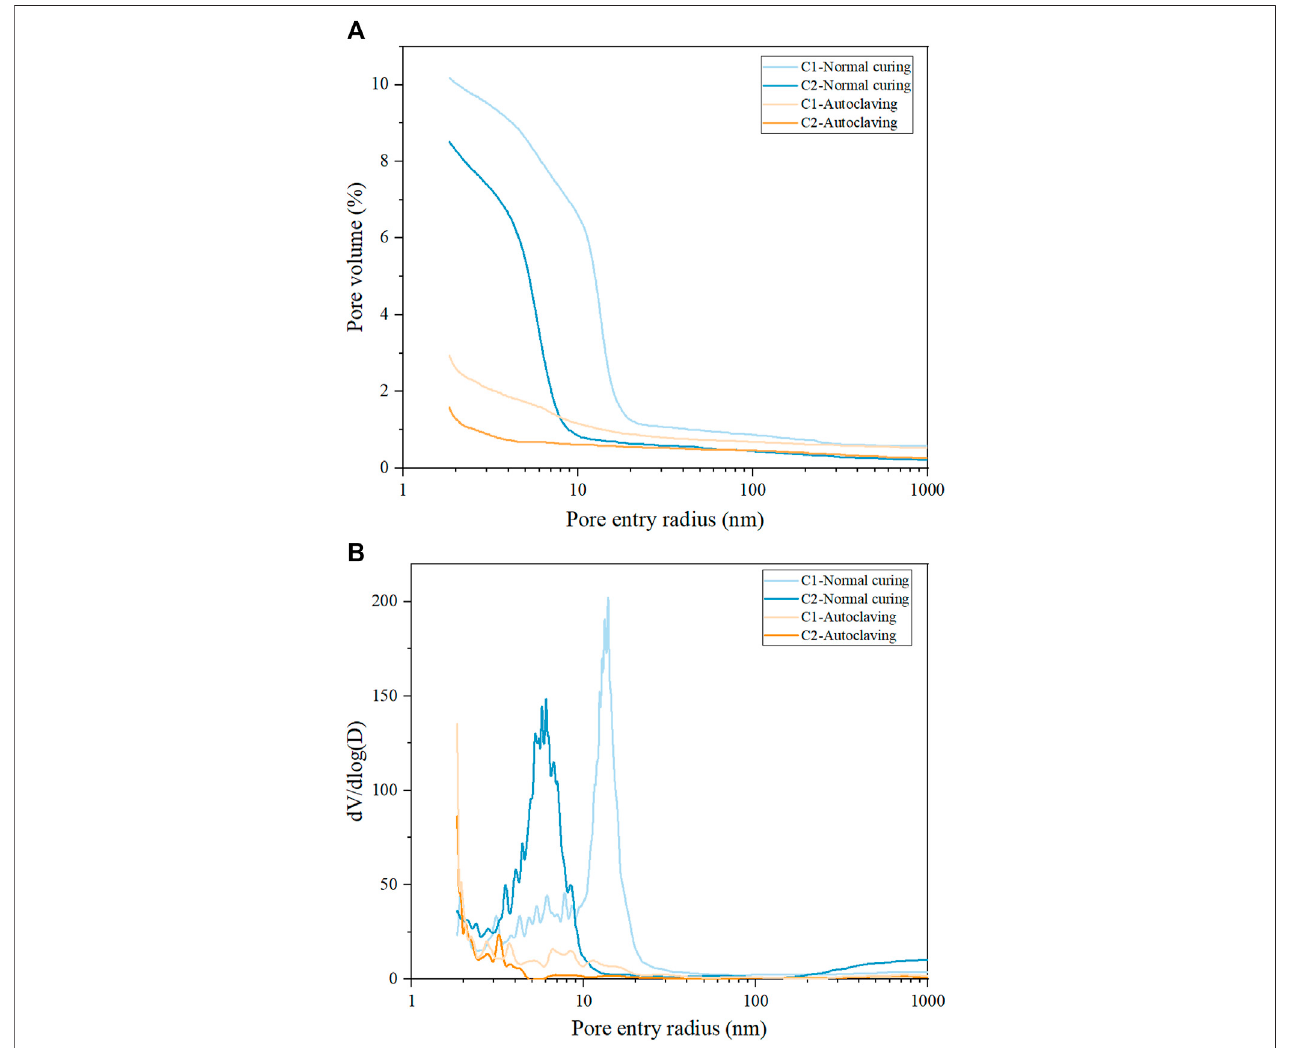
FIGURE 8 | Cumulative intrusion curves (A) and pore size distributions (B) obtained on the samples after different treatments.